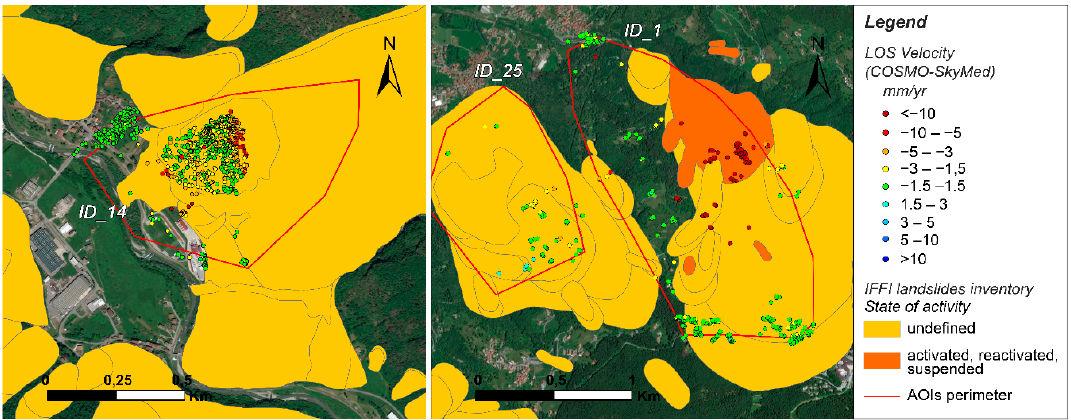
Figure 12. Examples of A-DInSAR results compared with the IFFI landslide inventory. for the AOIs ID_14, ID_1 and ID_25. ID_14, ID_1 and